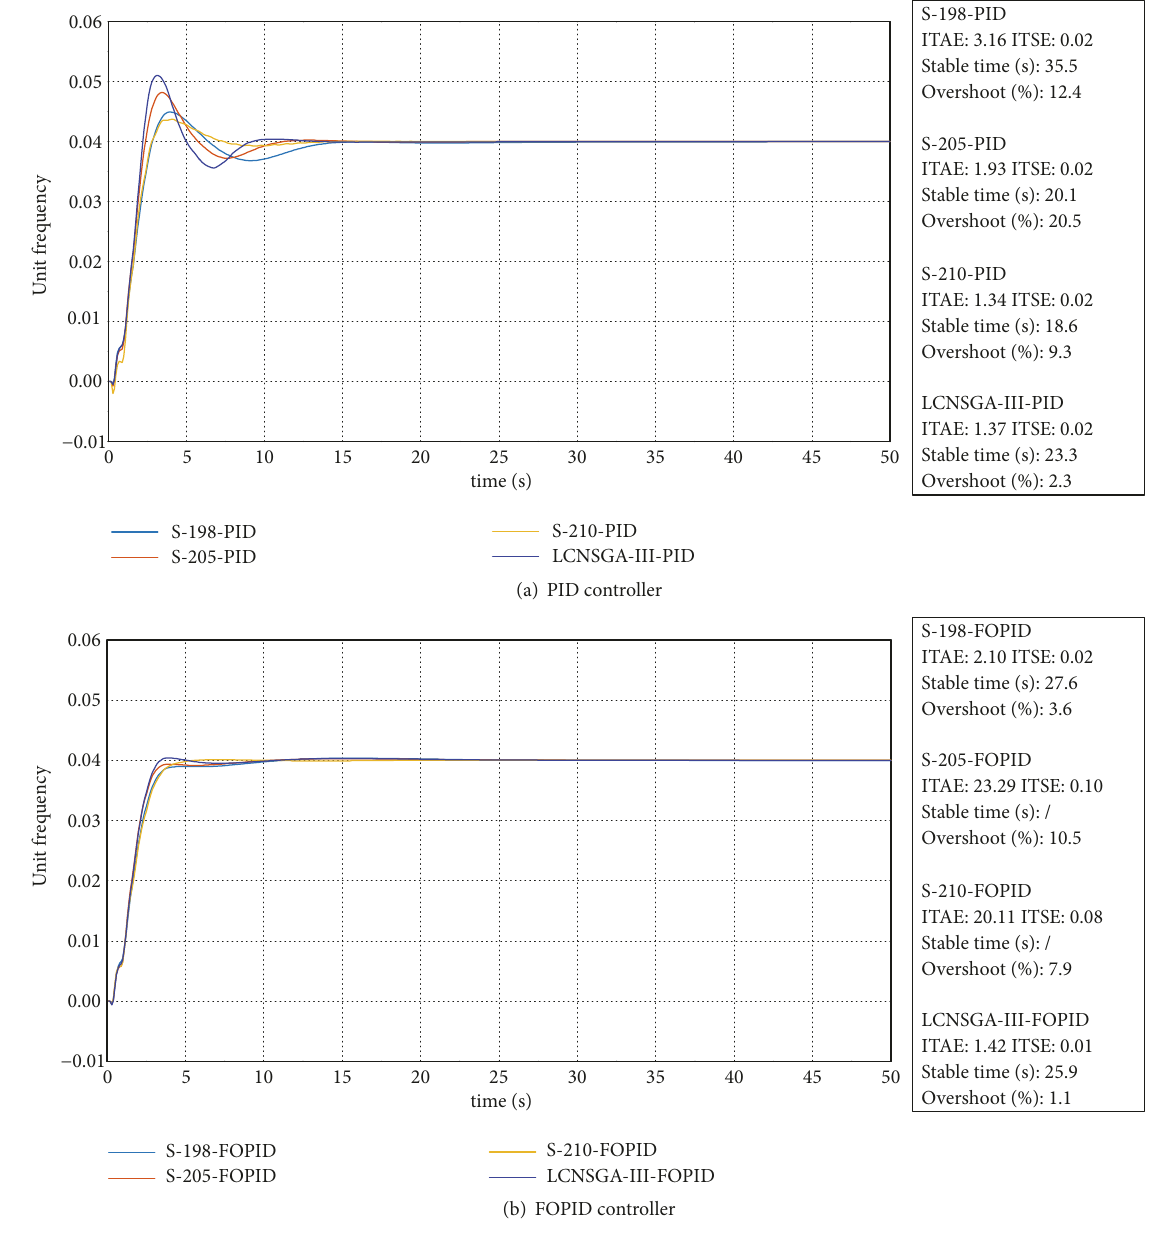
Figure 9: Unit frequency obtained at 210m working water